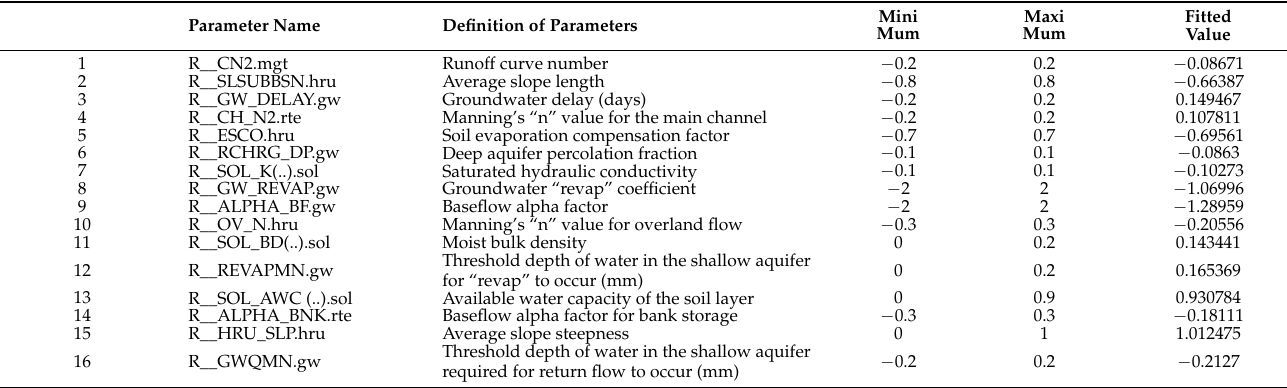
Table 4. Sensitive parameters used for calibration and